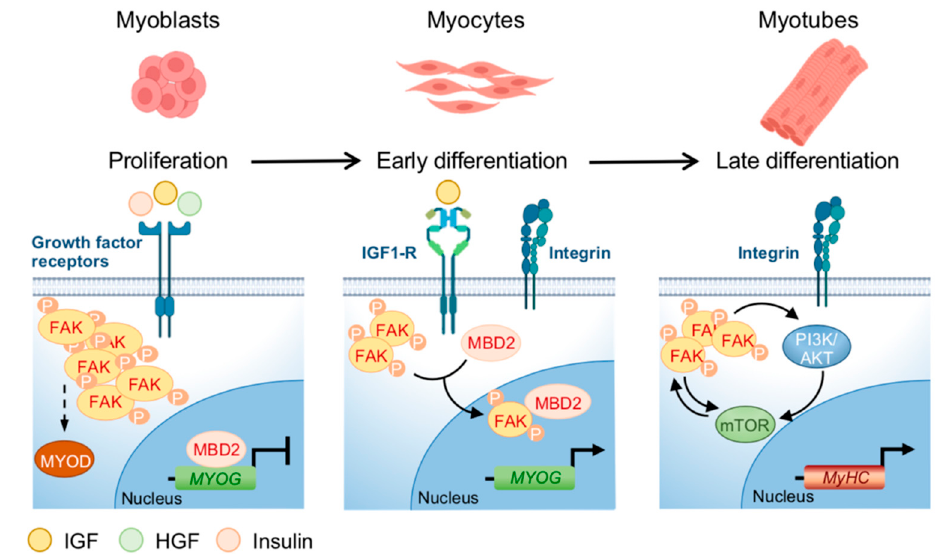
Figure 3. FAK regulation during myoblasts differentiation. The expression of FAK and its phosphorylation are related to specific points in the differentiation of myoblasts into myotubes. FAK is activated by growth factor receptors and regulates the development of myoblasts and the formation of muscle fibers. During the proliferation phase, the activation of growth factor receptors leads to FAK phosphorylation/activation, needed for MYOD expression, while the expression of MYOG is blocked by the binding of MBD2 to its promoter. In the early differentiation phase, phosphorylated-FAK fraction decreases and FAK cytoplasmic interaction with MBD2 promotes the translocation of the FAK/MBD2 complex into the nucleus, where MBD2 interaction with the MYOG promoter is prevented, leading to MYOG expression. During myotubes formation, FAK levels increase, even if not at the same level as in the proliferative phase. In this terminal phase, characterized by MyHC expression, integrins activation induces multiple pathways such as PI3K/AKT/mTOR which crosstalk with FAK to control protein synthesis and the size of the muscle fibers. Figure realized with BioRender.com.